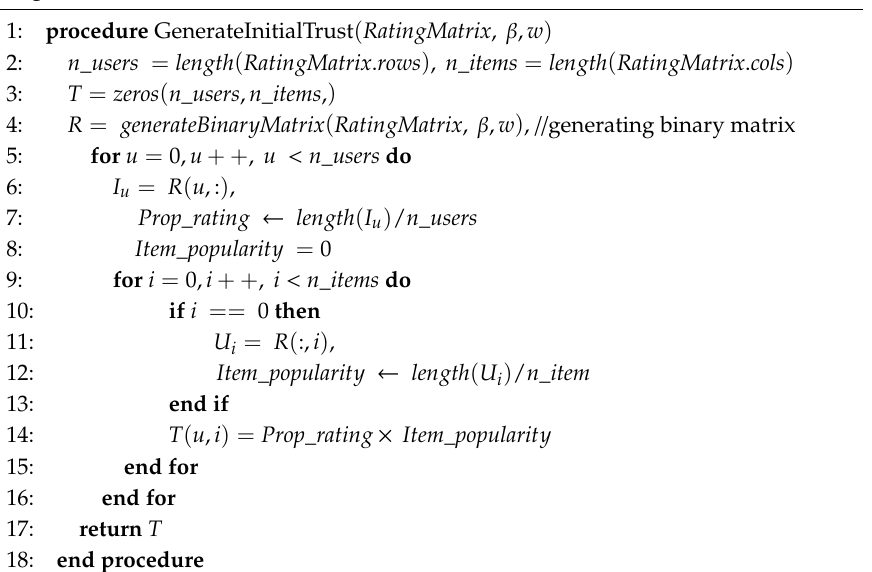
Algorithm 1 Pseudocode for initial trust